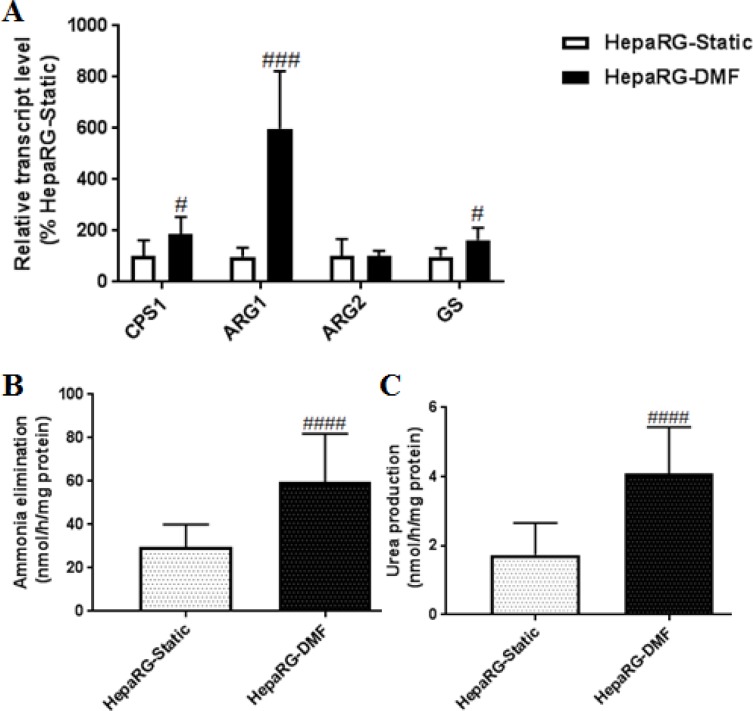
DMF-culturing improves nitrogen metabolism in HepaRG cells.(A) Transcript levels of genes involved in nitrogen metabolism, n = 6/group. (B-C) Ammonia elimination and urea production, n = 9-18/group. Significance Static vs DMF: # = P value <0.05, ## = P value <0.01, ### = P value <0.001 and #### = P value <0.0001.